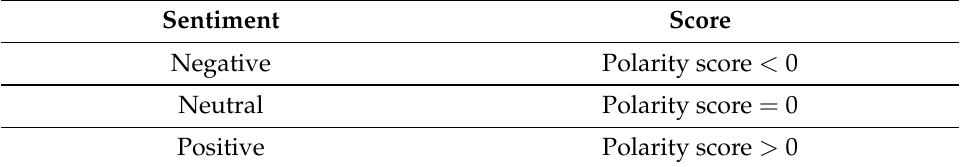
Table 8. AFINN sentiment score